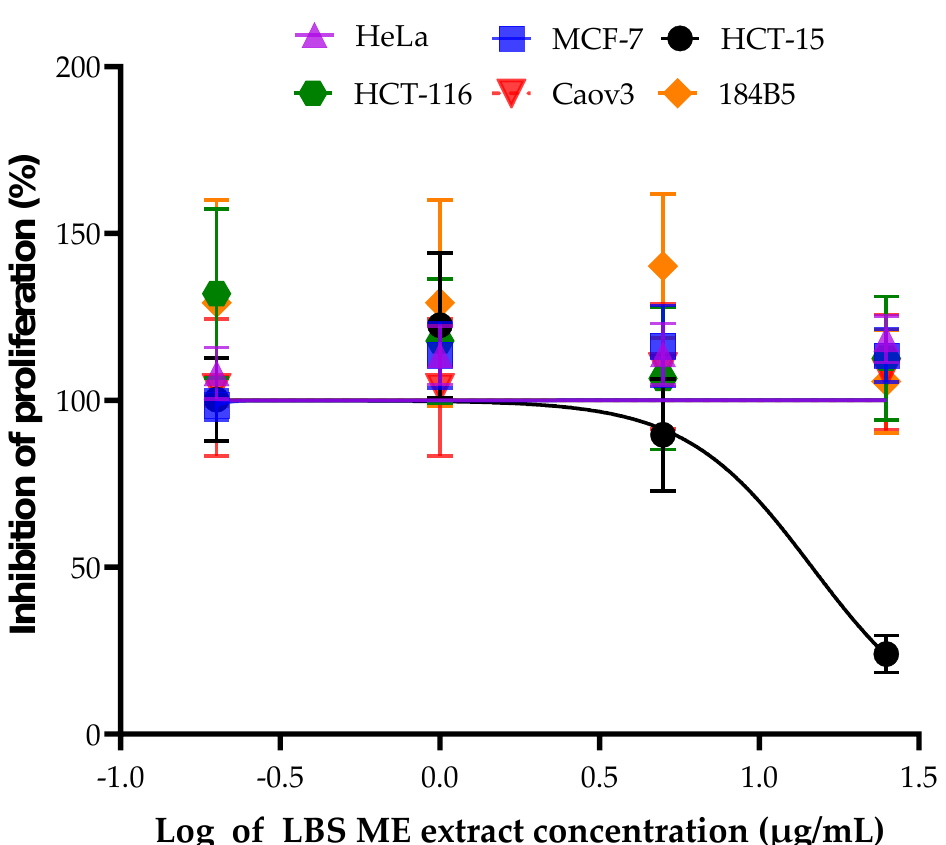
Figure 2. Dose–response of extracts of leaves of C. chinense grown on black soil (LBS), obtained by maceration (n = 3) against cancer cell lines (HeLa, MCF–7, HCT–15, HCT–116, Caov3) and breast normal cell line (184B5). IC 50 HCT–15 = 16.23 ± 2.89 µ g mL − 1 .